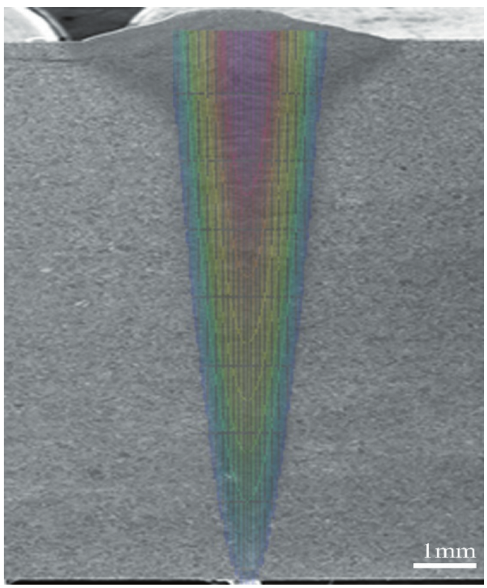
Figure 9: Simulation and experimental results of welding joint.